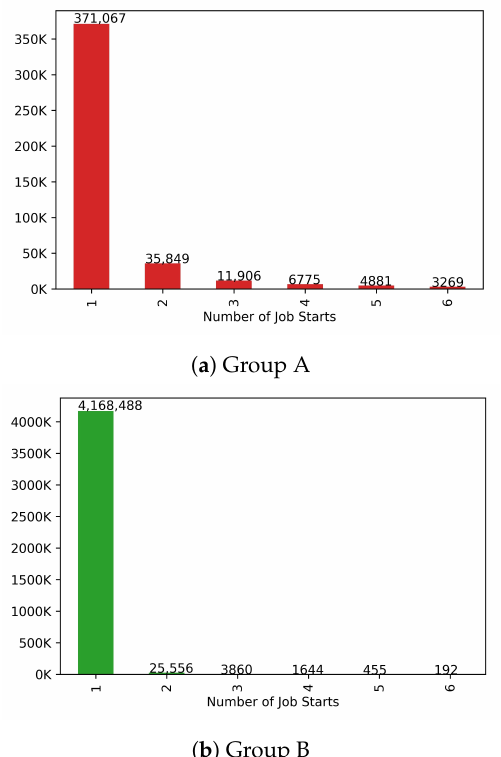
Figure 8. Job-start